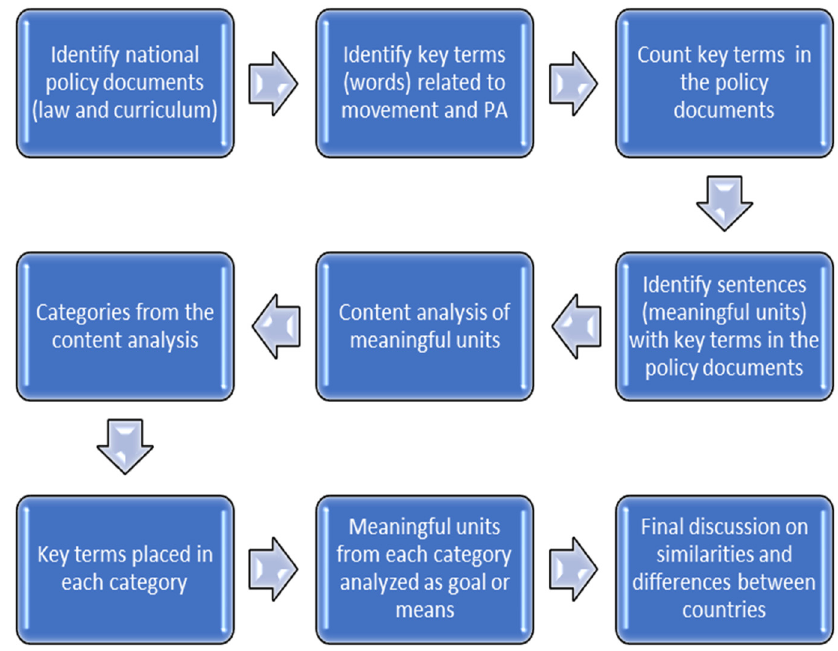
Figure 1. Flowchart depicting the steps in the research process.